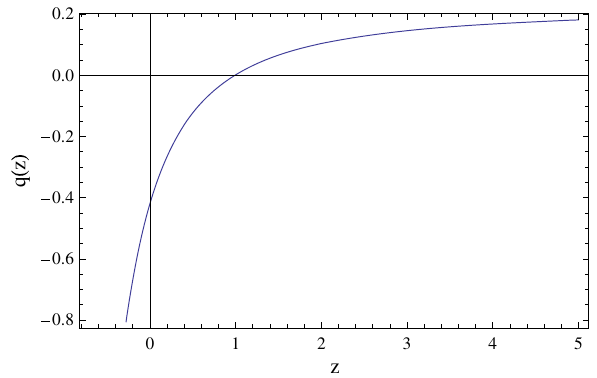
Fig. 11 Variation of q ( z ) with the variation of z (Model II) by con- sidering the best fit values w 0 = − 0 . 797 ,w 1 = 0 . 499